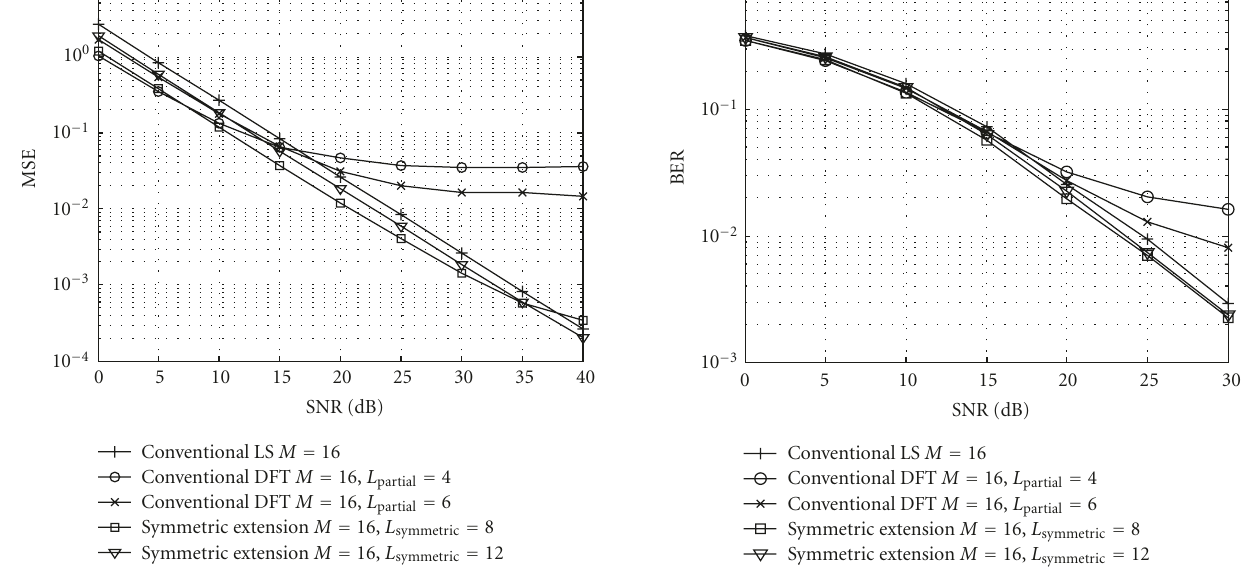
Figure 10: Comparing BER performance with proposed estimator, conventional DFT estimator, and LS estimator, when M = 16, L partial = 4 . 6, and L symmetric = 8 .